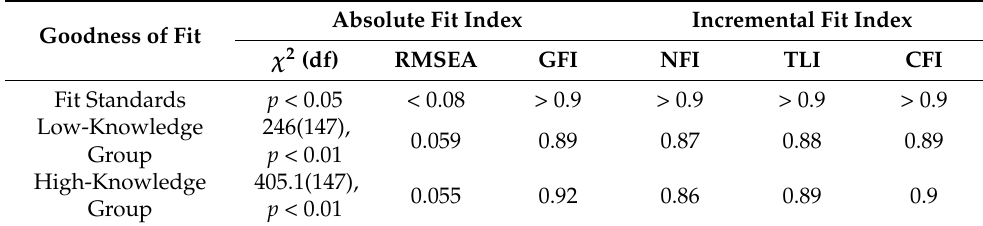
Table 6. Multiple fit indices to assess the two model fits. Goodness of Fit